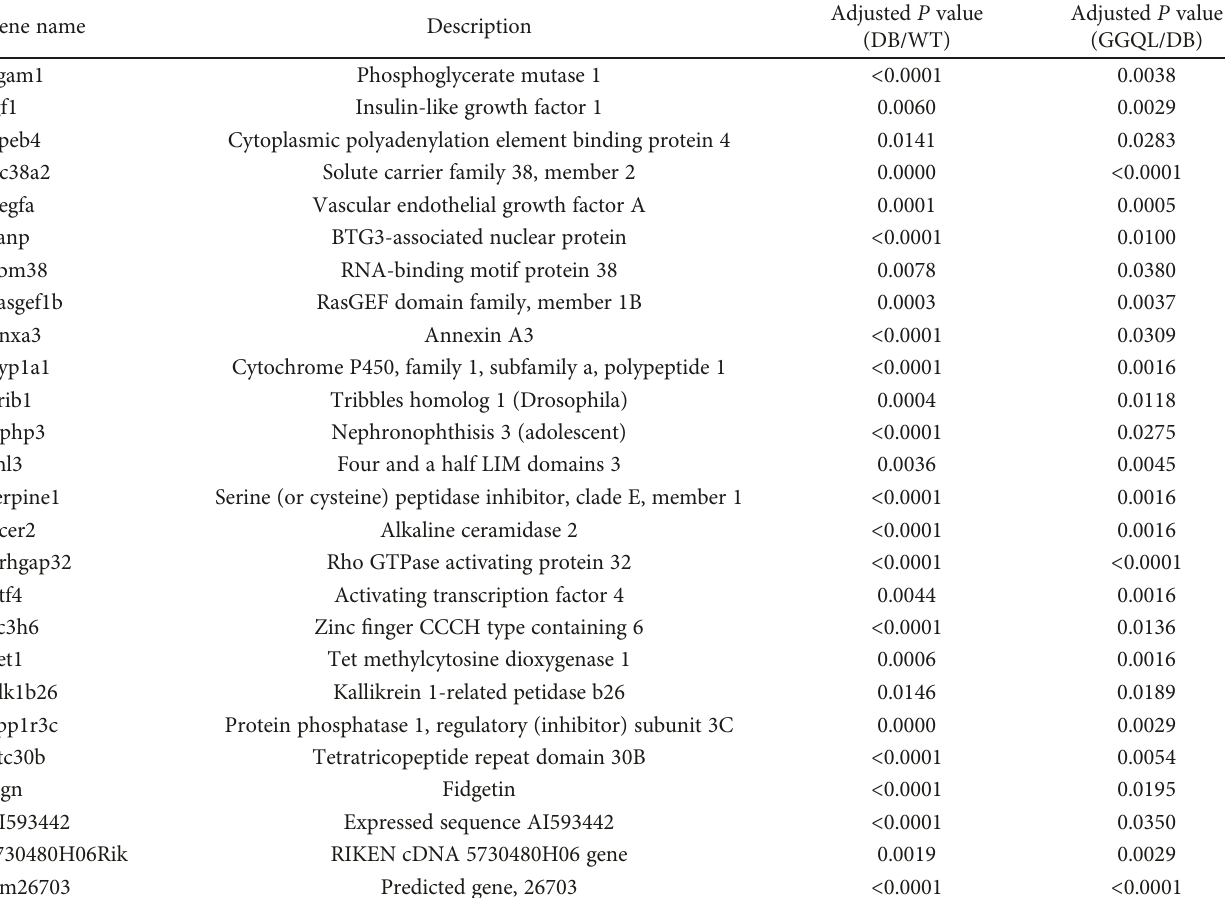
Table 2: Genes signi fi cantly regulated in the GGQL group versus the DB group and also signi fi cantly regulated in the DB group versus the WT